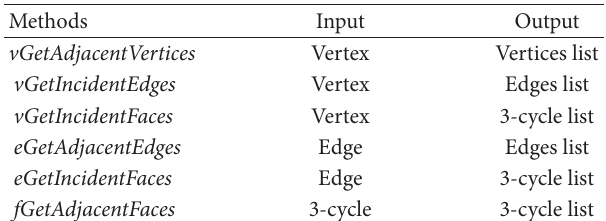
Table 1: List of the implemented methods in TopTri toolkit for getting topological relationships for vertices, edges, and cycles of length 3.